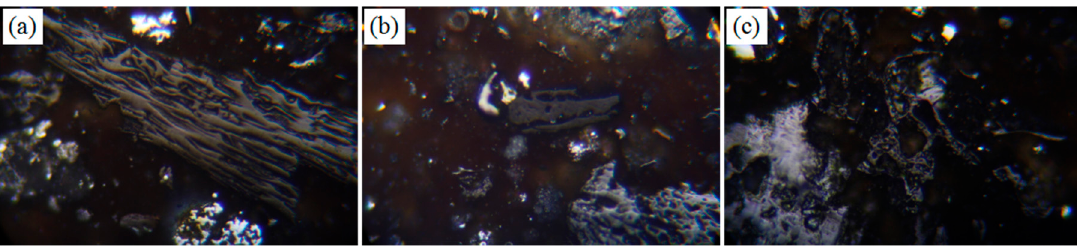
Figure 1. Microstructure of unconsumed pulverized coal in recycling dust: ( a ) completely unconsumed coal (CUC); ( b ) deformed coal (DC); and ( c ) residue coal (RC).